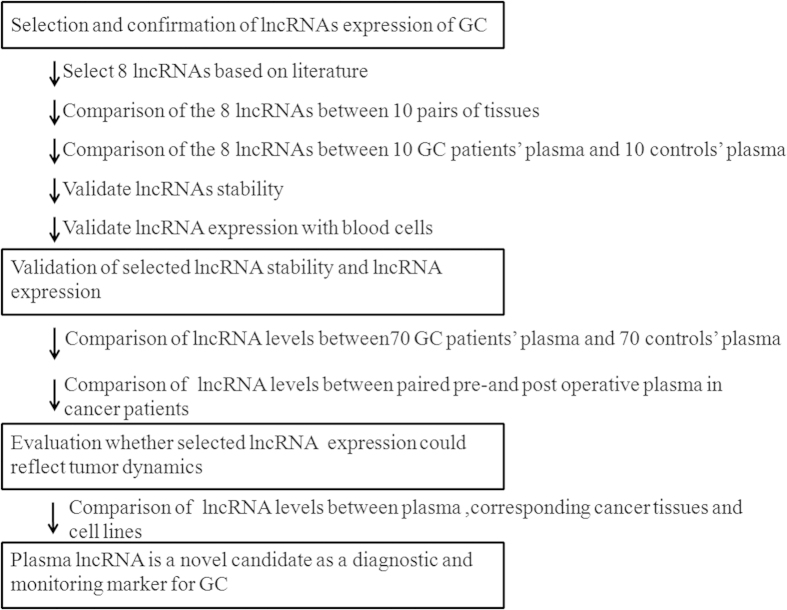
Study design to develop a novel biomarker of plasma lncRNA.